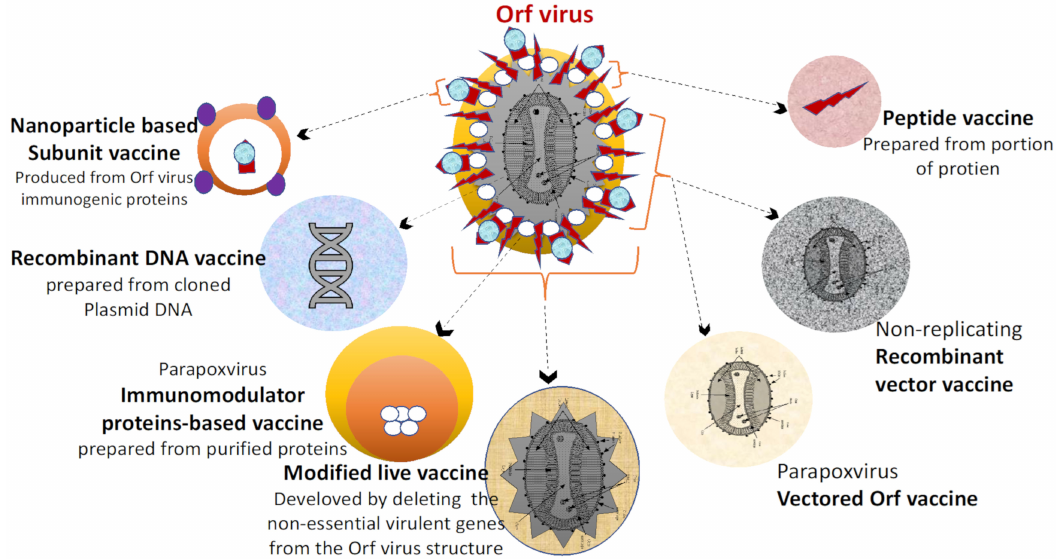
Figure 4. Schematic diagram outlining new strategies to address existing challenges in the design and development of vaccines against viral infections. Modified live attenuated, subunit, recombinant, cytokine and peptide vaccines have been used in modern vaccine